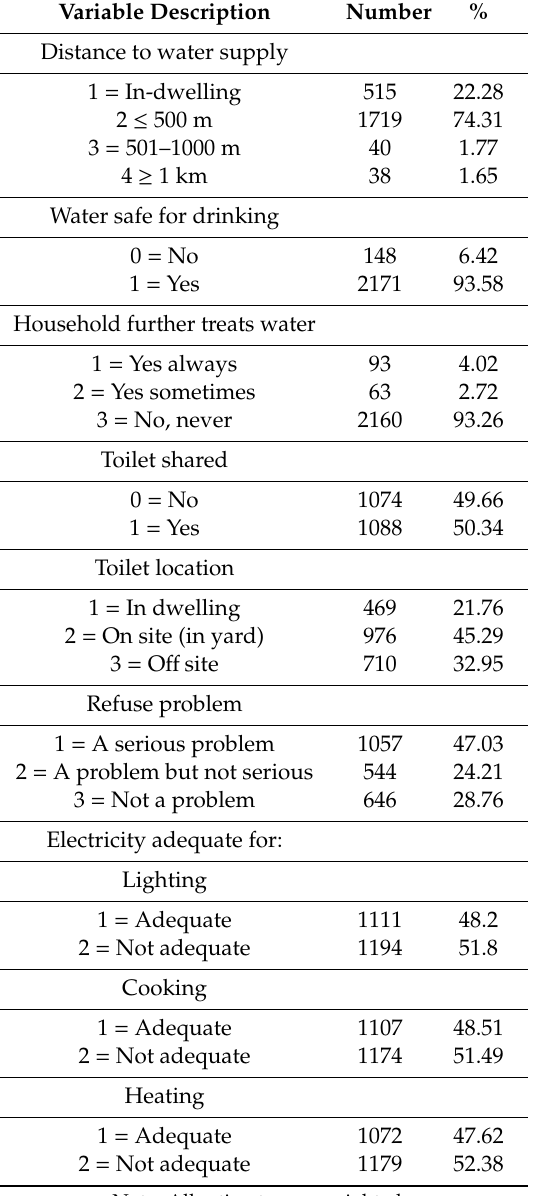
Table 2. Service-related